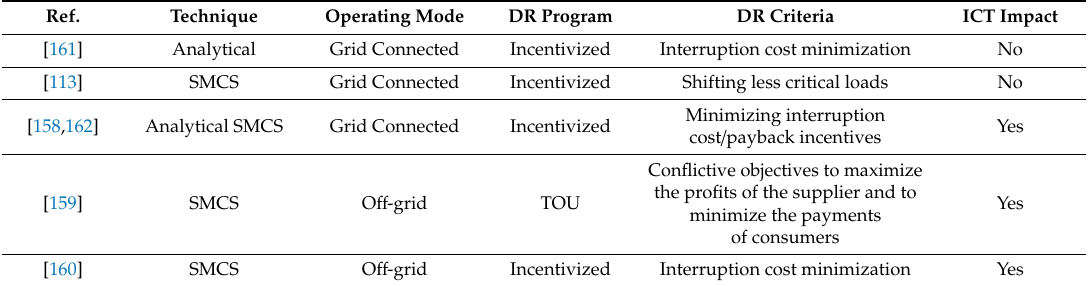
Table 6. Distinct propositions and techniques for reliability assessment of DRs in the literature [126].